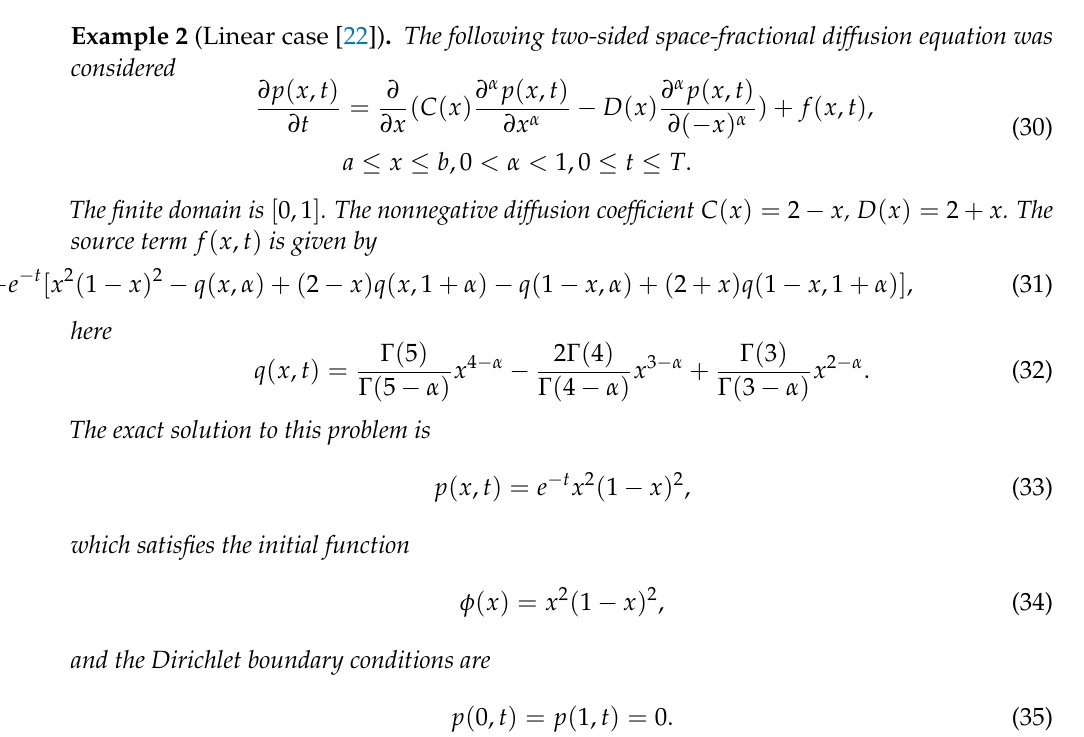
Figure 4. The numerical solution for the Crank-Nicolson scheme and the extrapolated Crank-Nicolson scheme and rate for Example 1 with α = 0.8, ∆ t = h = 2 − 6 at time T =